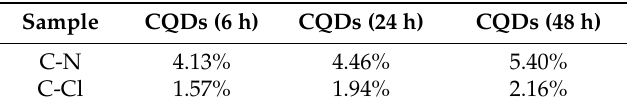
Figure 11. High-resolution C 1s, N 1s, O 1s and Cl 2p core level XPS spectra of CQDs (6 h) ( a – d ), CQDs (24 h) ( e – h ) and CQDs (48 h) ( i – l ). Table 3. Intensity proportion of C–N and C–Cl in the C1s spectra of CQDs (6 h), CQDs (24 h) and CQDs (48 h).